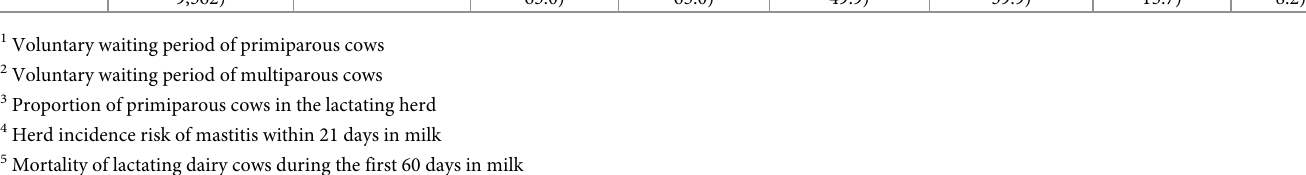
The final multivariable mixed effect regression model showed that milk yield, % mastitis, % primiparous, and VWP-M were not associated (p < 0.16) with IR. The variables retained in the final multivariable regression model were housing system, season of the year, % dead, and (Table 3). Insemination risk was associated with season of the year because IR was greatest during autumn. Nonetheless, IR did not differ among winter, spring, and summer (p > 0.16). In addition, % dead and VWP-P were associated (p < 0.01) with IR (Table 3).